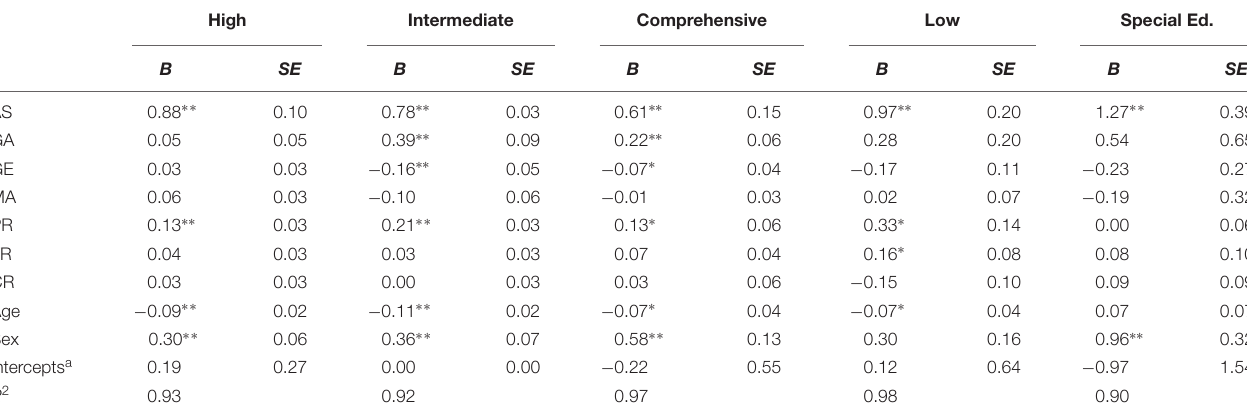
TABLE 4 | Results of regression analyses predicting self-esteem for the different ability tracks. High Intermediate Low Special